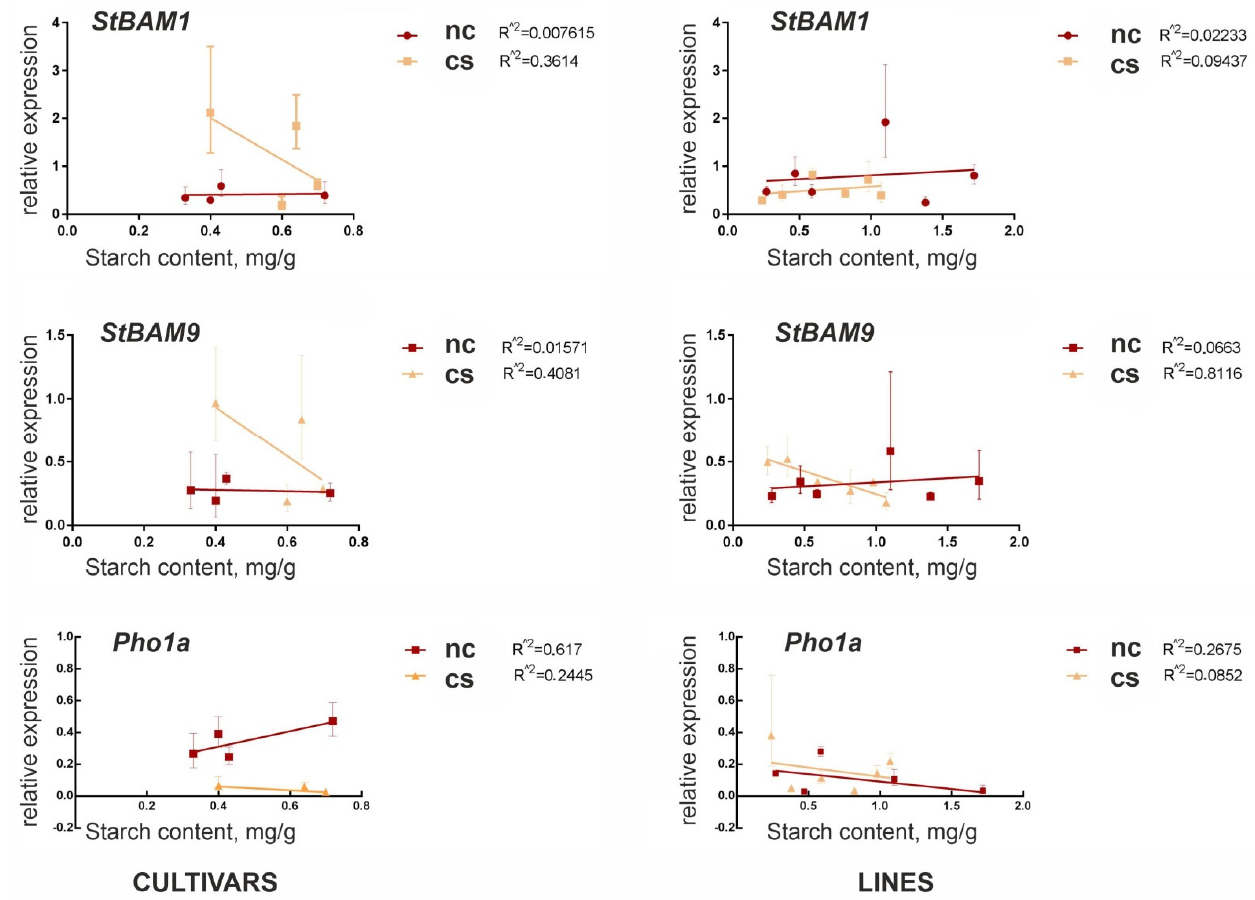
Figure 5. Correlation between PHO1a , StBAM1 , and StBAM9 expression and starch content in the leaves of potato cultivars and transgenic lines in normal growth conditions (+21 °C; nc) and in response to cold stress (+4 °C for 3 days; cs). R 2 > 0.4 indicates significant correlation. There was no correlation between StBAM1 expression and starch